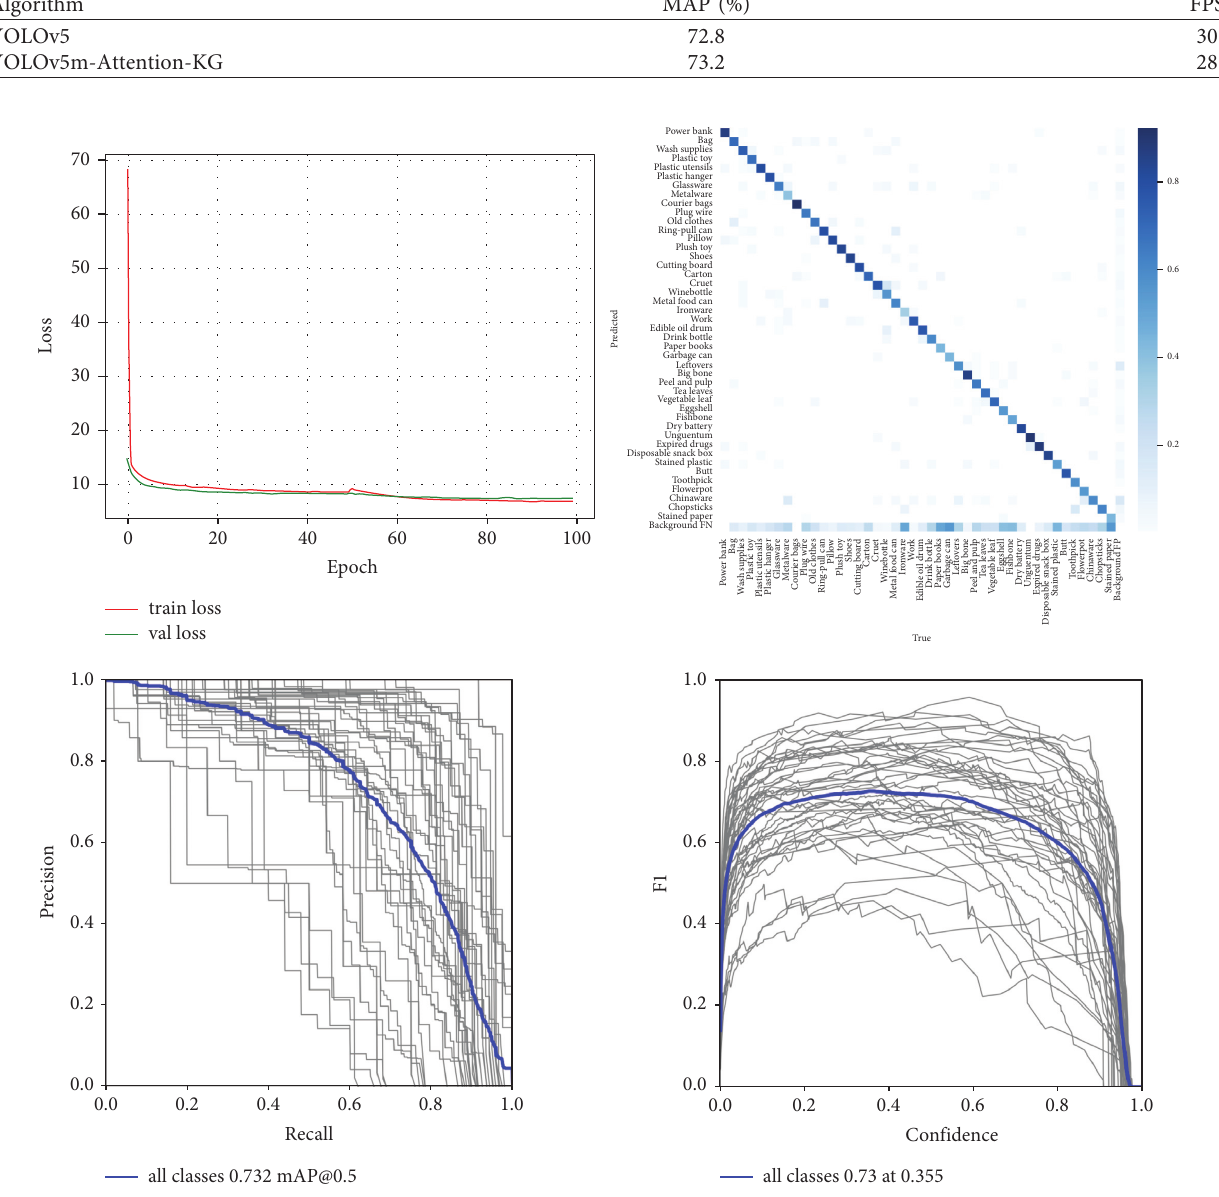
Figure 8: Part of the evaluation index.